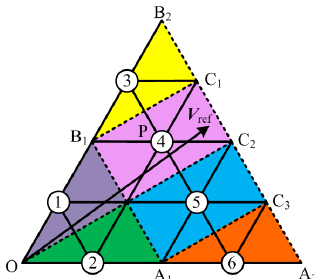
Figure 6. Diagram of region partition in Sector I.